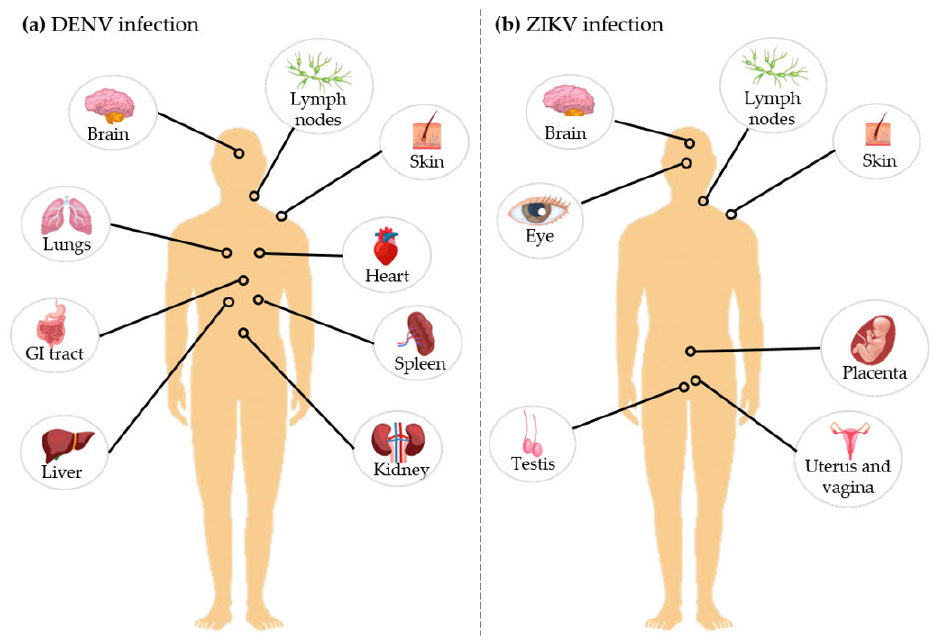
Figure 4. Dengue and Zika viruses tissue tropism. Representative target-organs of ( a ) DENV and ( b ) ZIKV are highlighted. This image has been designed using resources from